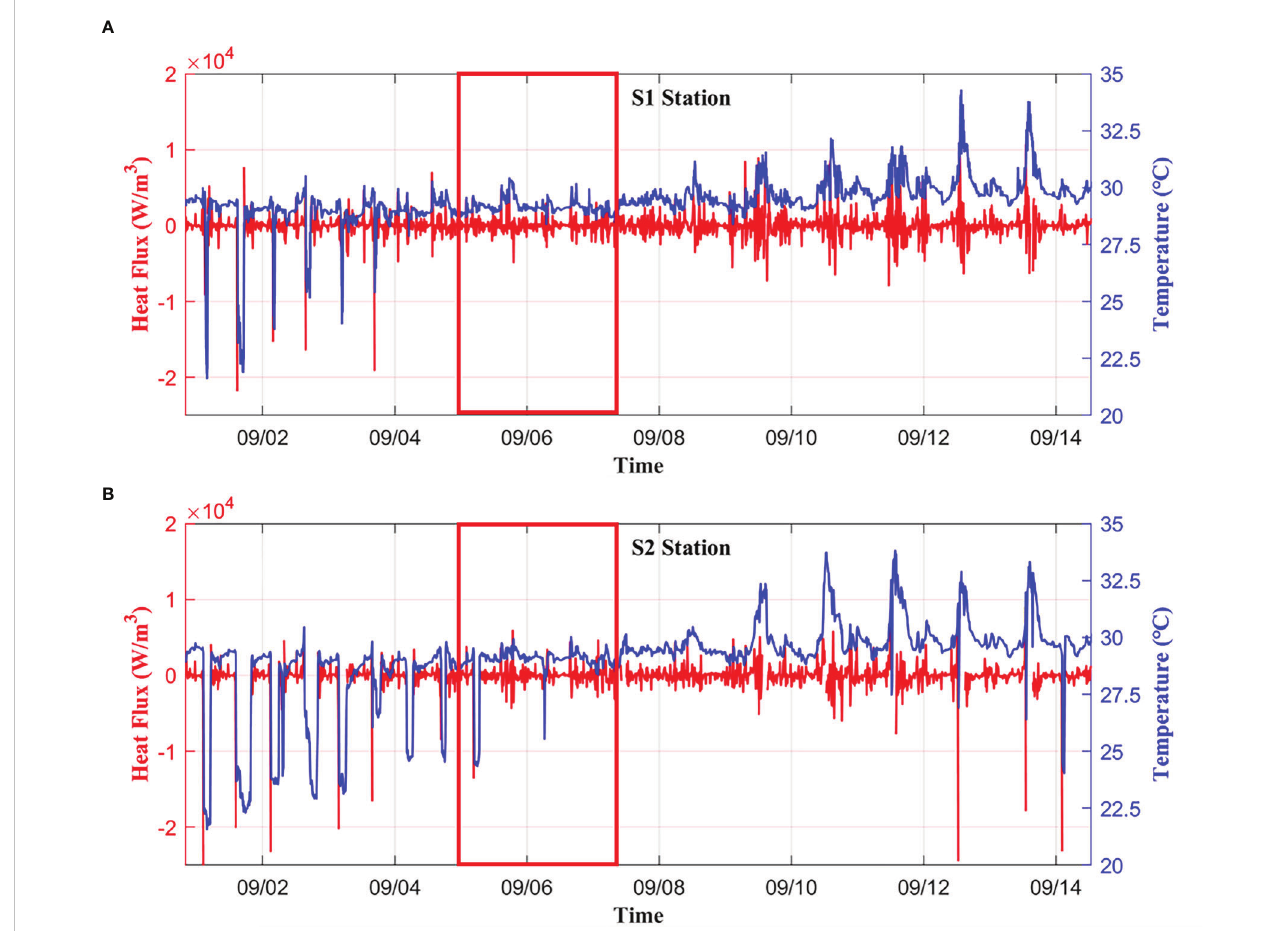
FIGURE 11 Relationship between heat fl uxes and sea water temperature at (A) station S1 and (B) station